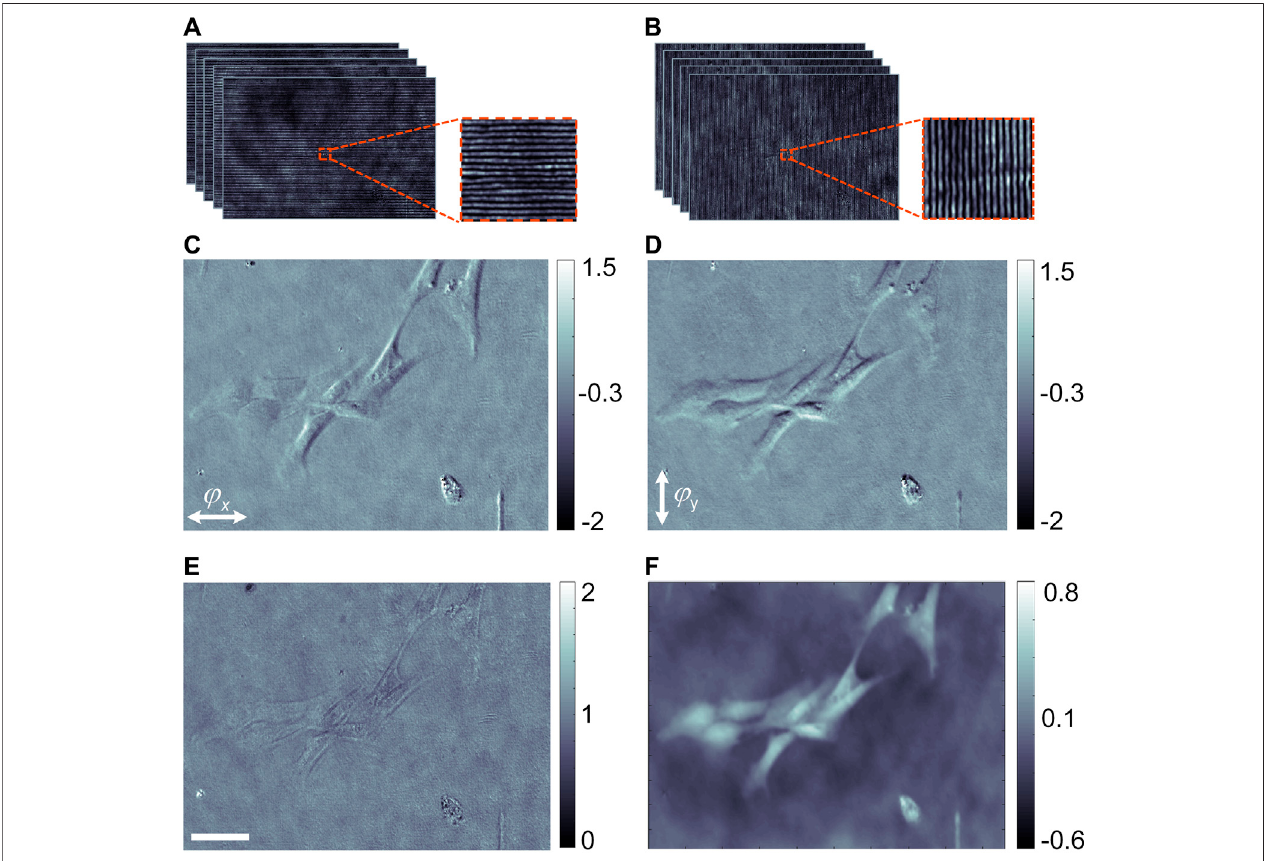
FIGURE 2 | qDIC imaging of mouse adipose stem cells. (A,B) The diffraction patterns along the x - and y -directions; (C,D) reconstructed phase derivatives of the cells along the x- and y- orientations, respectively; (E,F) reconstructed amplitude and phase distribution of the mouse adipose stem cells, respectively. The scale bar in (E) , 40 μ